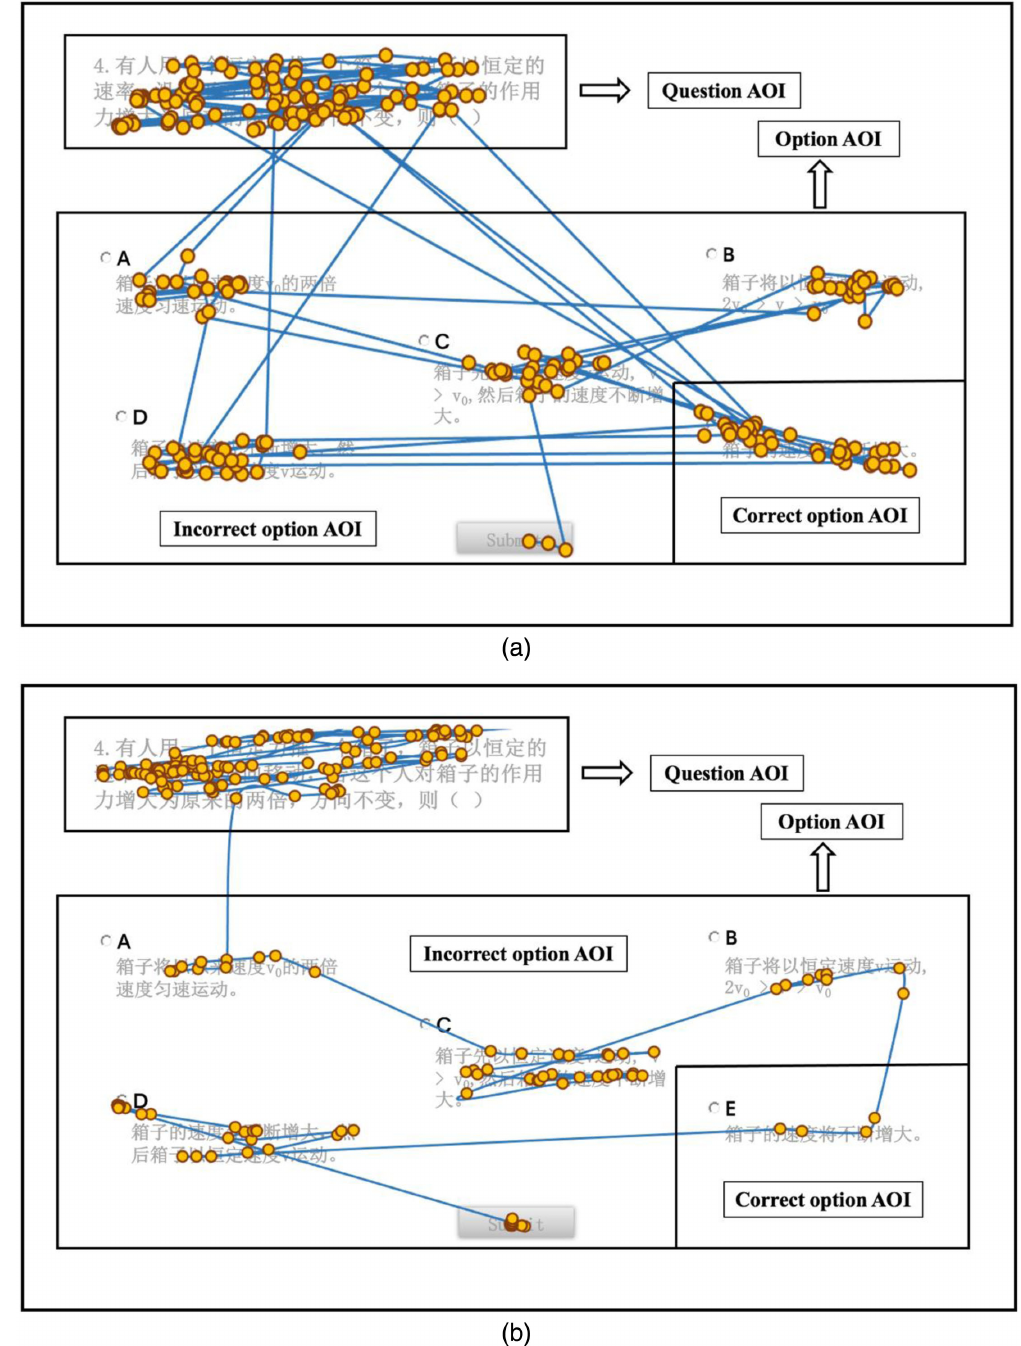
FIG. 4. (a) The scan path of a successful problem solver (participant E) when solving item 4 (FCI question 26 [69]). (b) The scan path of an unsuccessful problem solver (participant F) when solving item 4 (FCI question 26 [69]). Circles and solid lines represent the fixations and